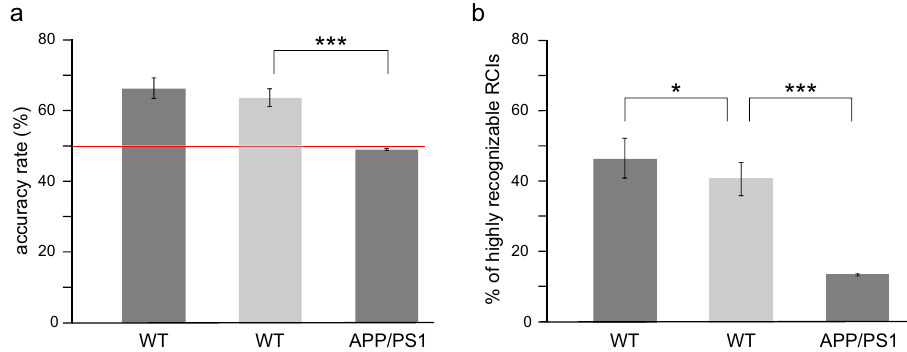
Figure 6. Successful not frequency-based classification of RCIs in the WT mice. (a , b ) After equalizing the frequency distribution of the pre- and post-learning SWRs in the training pool the average AR ( a ) and HR RCIs ( b ) were still significantly higher in the WT than in APP/PS1 group (AR: p = 0.0004, t = 5.8035; HR RCIs: p = 0.0004, t = 5.8035, t-test with Bonferroni correction). However, in the WT group, the average value of HR RCIs was slightly lower compared to the experiment with full frequency ( p = 0.0485, t = 3.1831, t-test with Bonferroni correction) ( b ). In the WT group, dark bars represent the mean value of AR and HR RCIs in the experiment with full frequency and light bars in the experiment with the equalized frequency of SWRs. Other abbreviations as in Fig. 2.